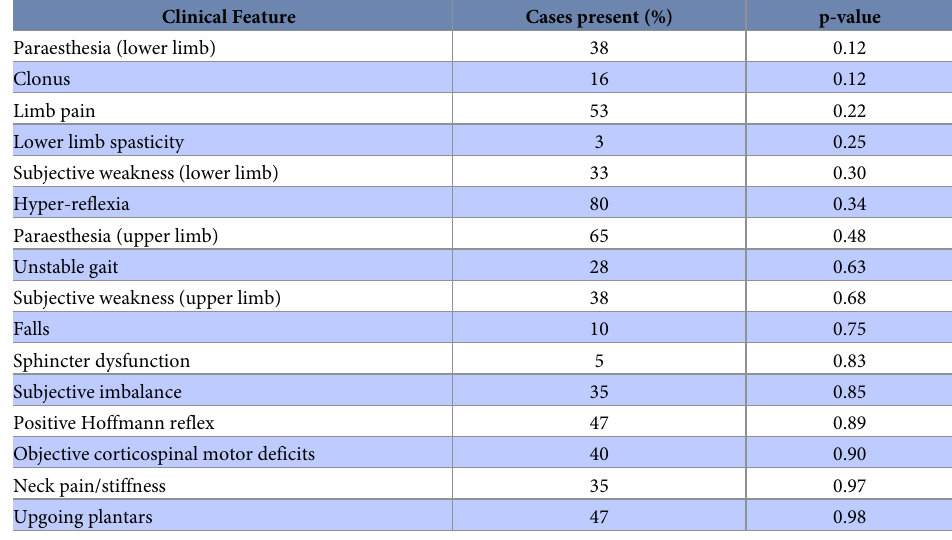
Table 2. The relationships between clinical features and the decision to operate ordered by ascending p-value. Number of DCM cases the feature was recorded as present in as a percentage of total cases.